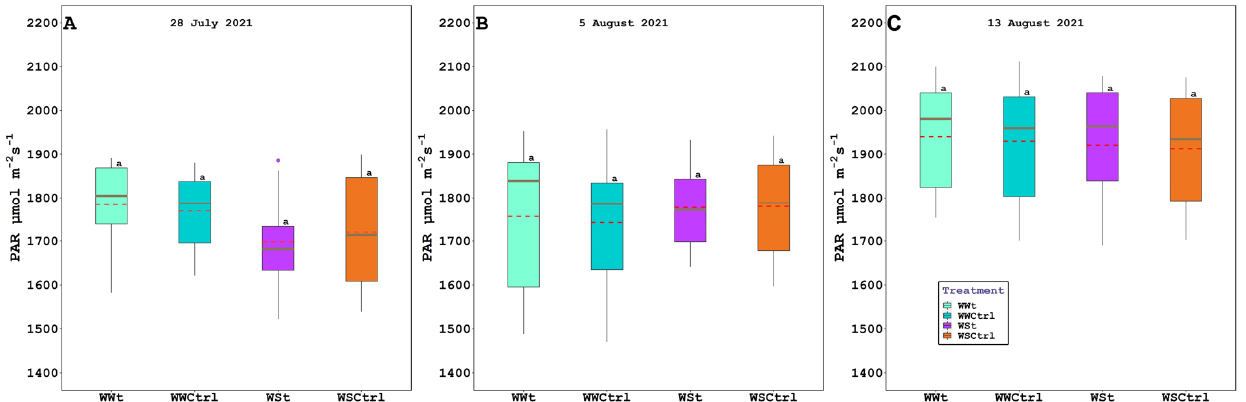
Figure 2. Photosynthetically active radiation (PAR; µmol m − 2 s − 1 ) in Vitis vinifera (Pinot Noir cv.) treated with Zeolite (t) and untreated plants (Ctrl), under two irrigation regimes (WW, well-watered; WS, water-stressed); ( A ). 28 July 2021, ( B ). 5 August 2021, and ( C ). 13 August 2021. The box bounds show the 25 and 75 percentiles, and the error bars the 90 and 10 percentiles. The black continuous and red discontinuous lines inside the boxes represent medians and means, respectively. Outliers are represented as color dots. Average values with the same letter in each figure indicate no significant differences between plots ( p < 0.05).